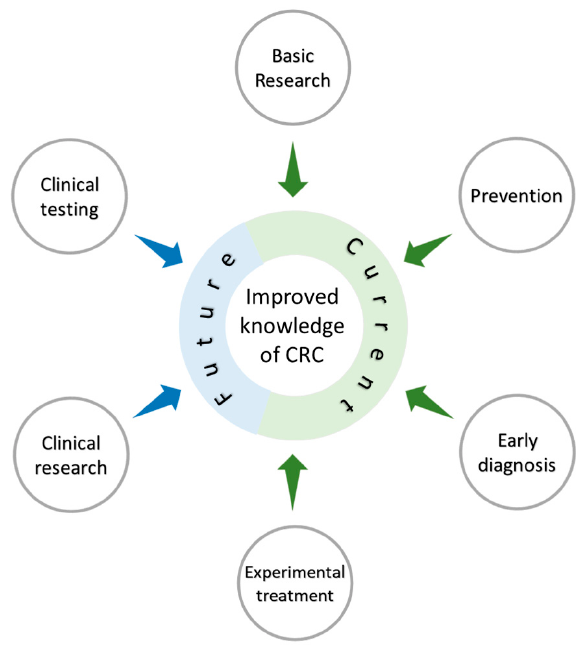
Figure 5. The Mexican Colorectal Cancer Research Consortium (MEX-CCRC) was developed to boost research on CRC in Mexico. The MEX-CCRC started impacting on the basic biomedical research of this field by characterizing immunological and molecular aspects of this pathology, and discovered biomarkers based on phenotypic characterization, which could ultimately lead to prevention and early diagnosis. Experimental treatments have also been tested with the possibility of doing in future clinical research that may result in the reduction and improvement of the disease.